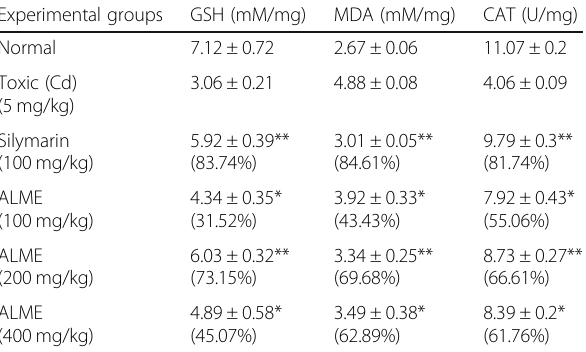
Table 4 Effect of ALME on different antioxidant parameters in the kidney